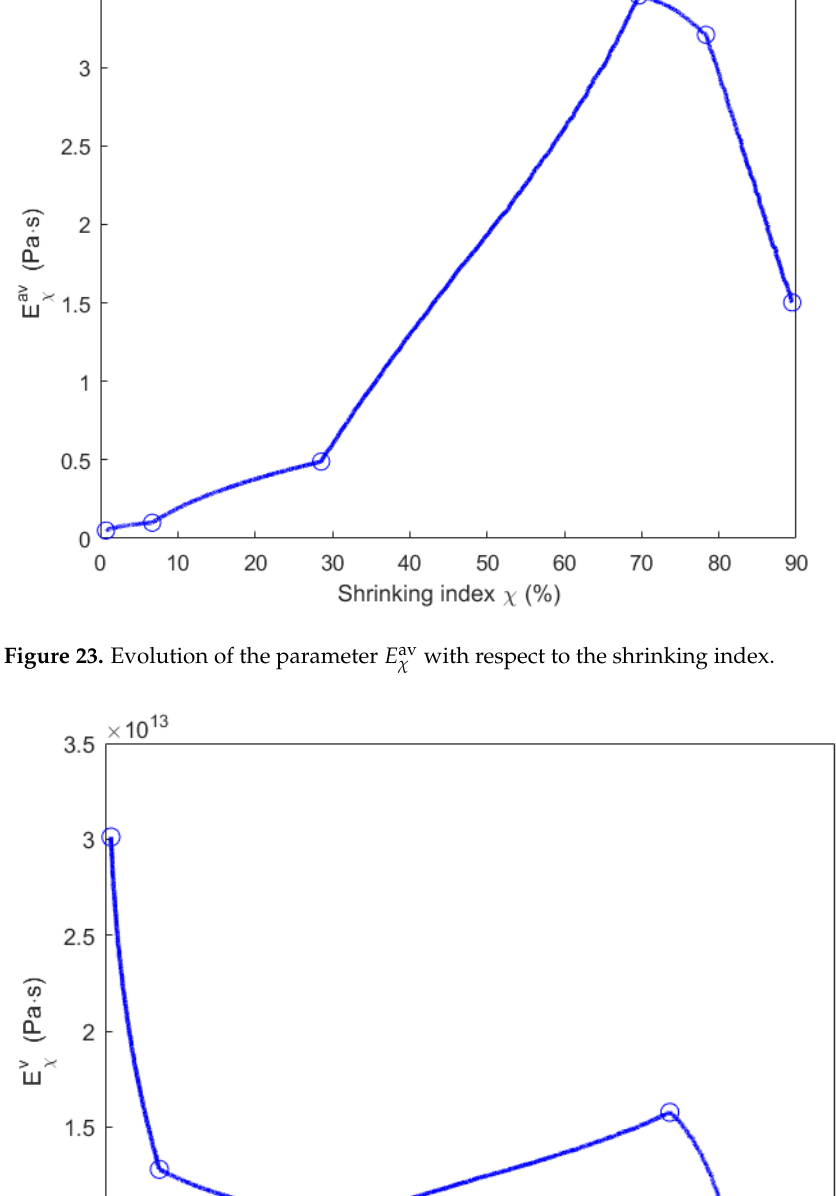
ae E χ with respect to the shrinking index.